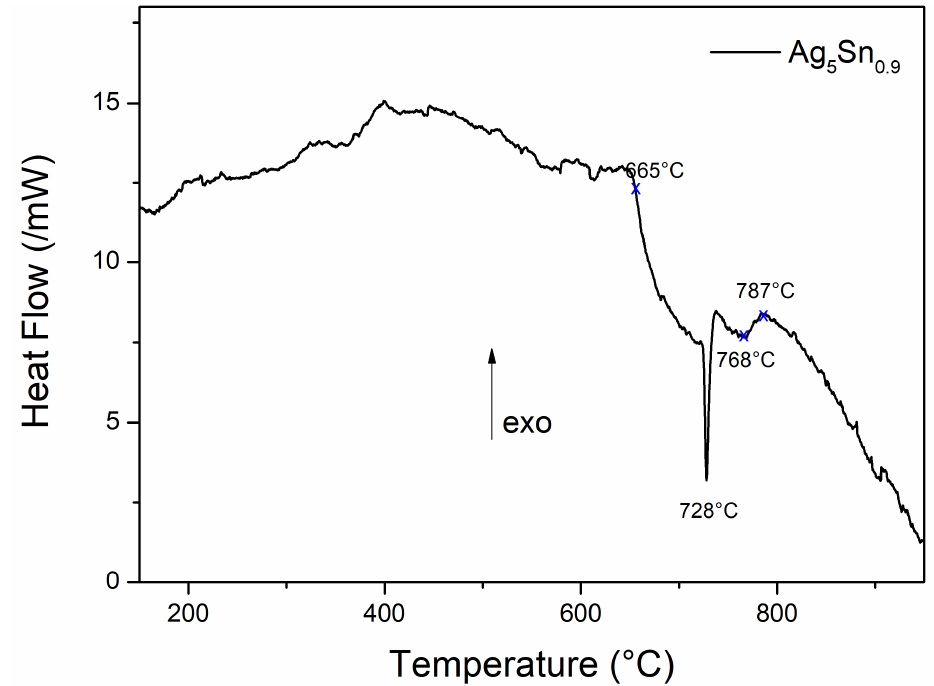
Figure 1. Thermogram of Ag 5 Sn 0.9 particles.